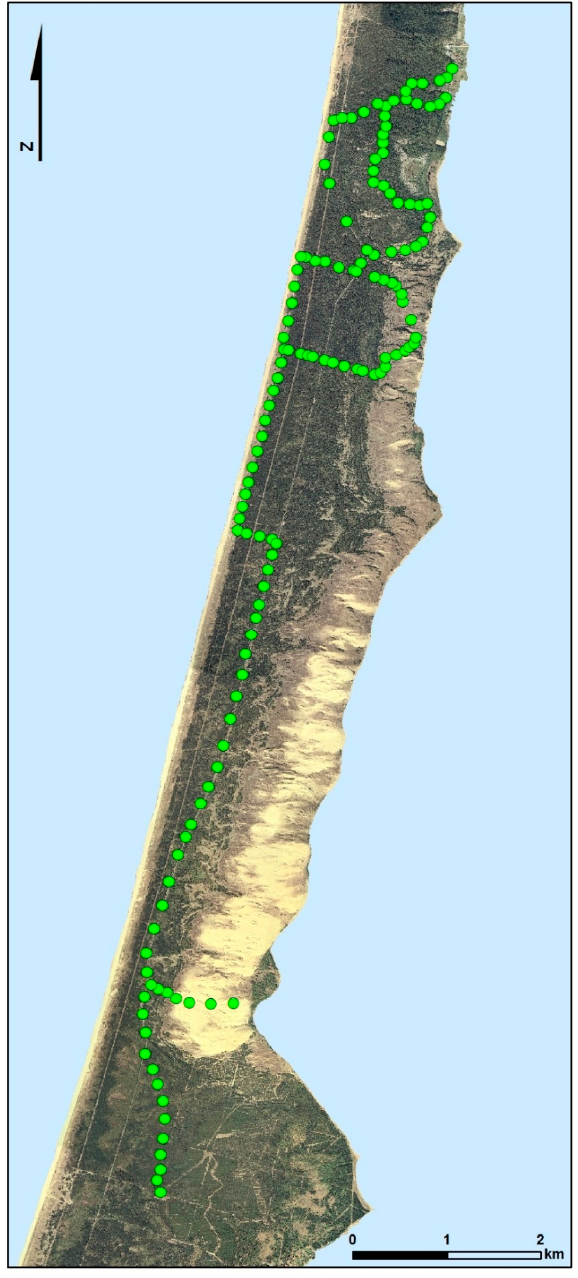
Figure 9. The hiking route in Nagliai Strict Nature Reserve and its buffer zone with the points of the field validation of the simulated aesthetic appeal values. (Drawn by Egidijus Jurkus).